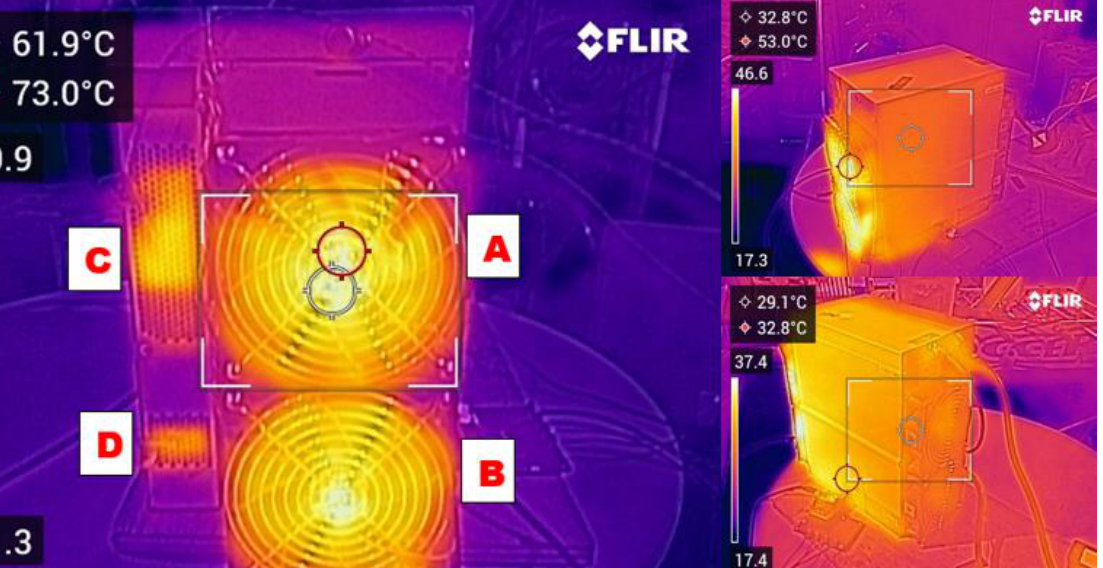
Figure 7. Antminer S17e heat exhaust over a 24 h period measured in degrees Celsius. Temperature 1 refers to heat exhausted from the top main fan of the Antminer. Temperature 2 refers to the heat exhausted from the bottom main fan of the Antminer. Putting the measured values of temperature and volumetric flow rates in Equation (5), the waste heat of the Antminer is obtained around 3.24 kW, which shows that the power consumed by the miner is almost completely converted to waste heat. 4.3. Experimental ASIC Chip Temperature Each ASIC chip takes approximately 5 min to reach maximum temperature before stabilizing wit hin a narrow range. ASIC chip 1′s temperature fluctuated between 60 ℃